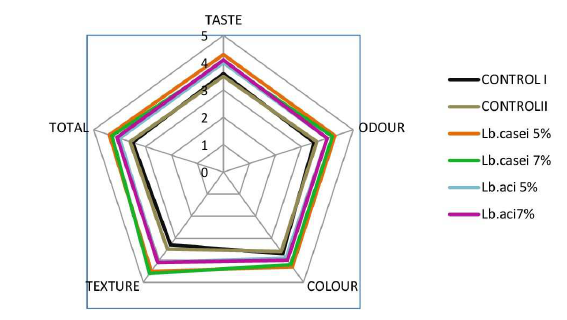
Figure 5. Sensory profile of pickle samples during the storage of 30